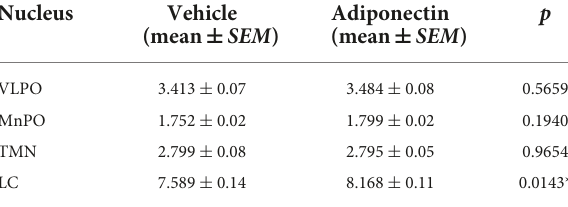
TABLE 1 Optical density of GAD65 expression in adiponectin protocols.